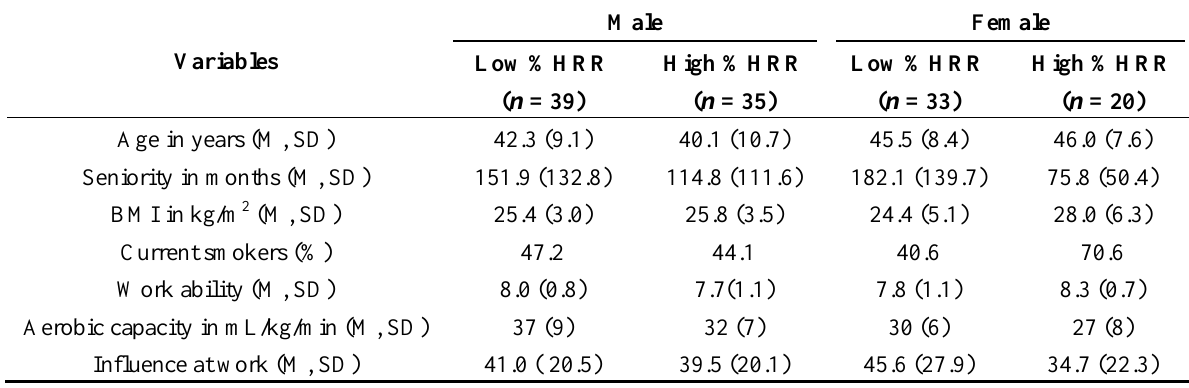
Table 2. Demographic characteristics of the male and female workers stratified on